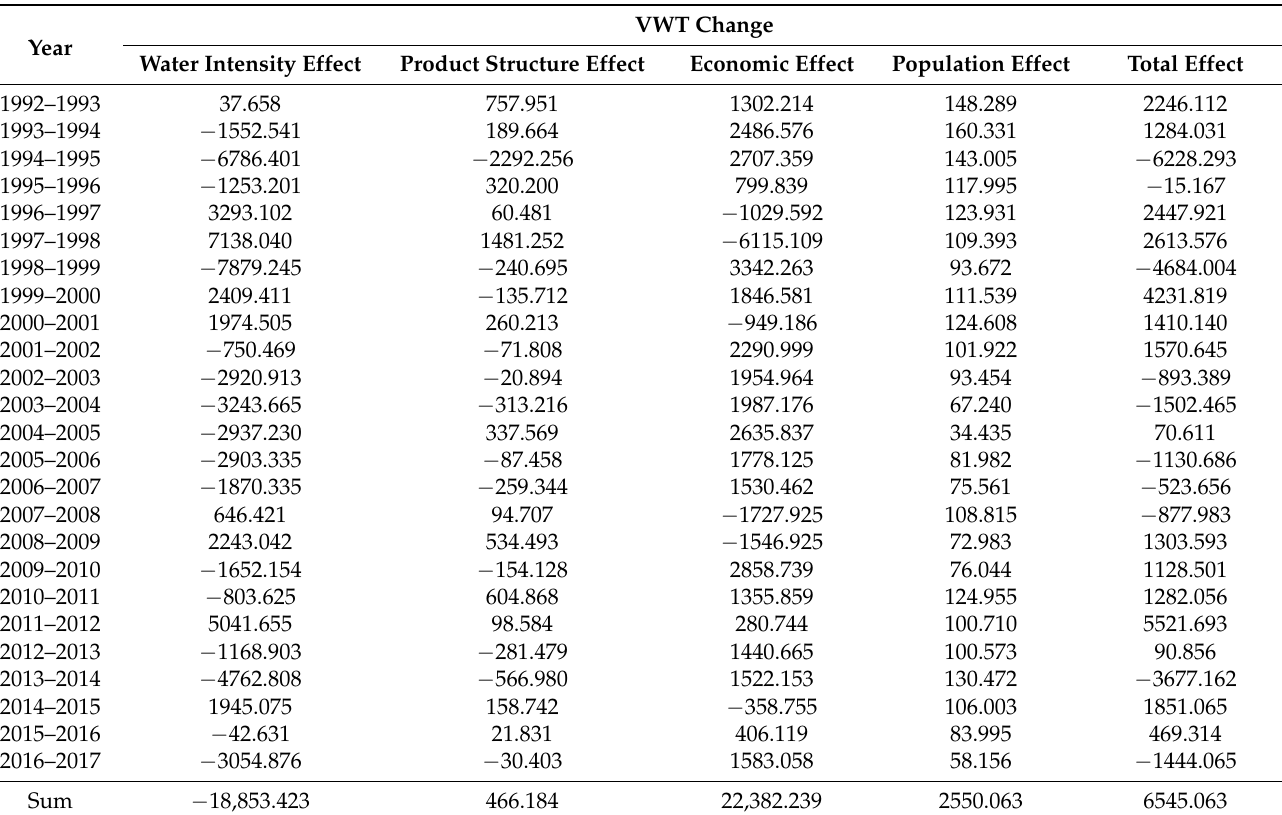
Table 5. The logarithmic mean divisia index (LMDI) analysis of grain virtual water trade (VWT) change in South Korea (million m 3